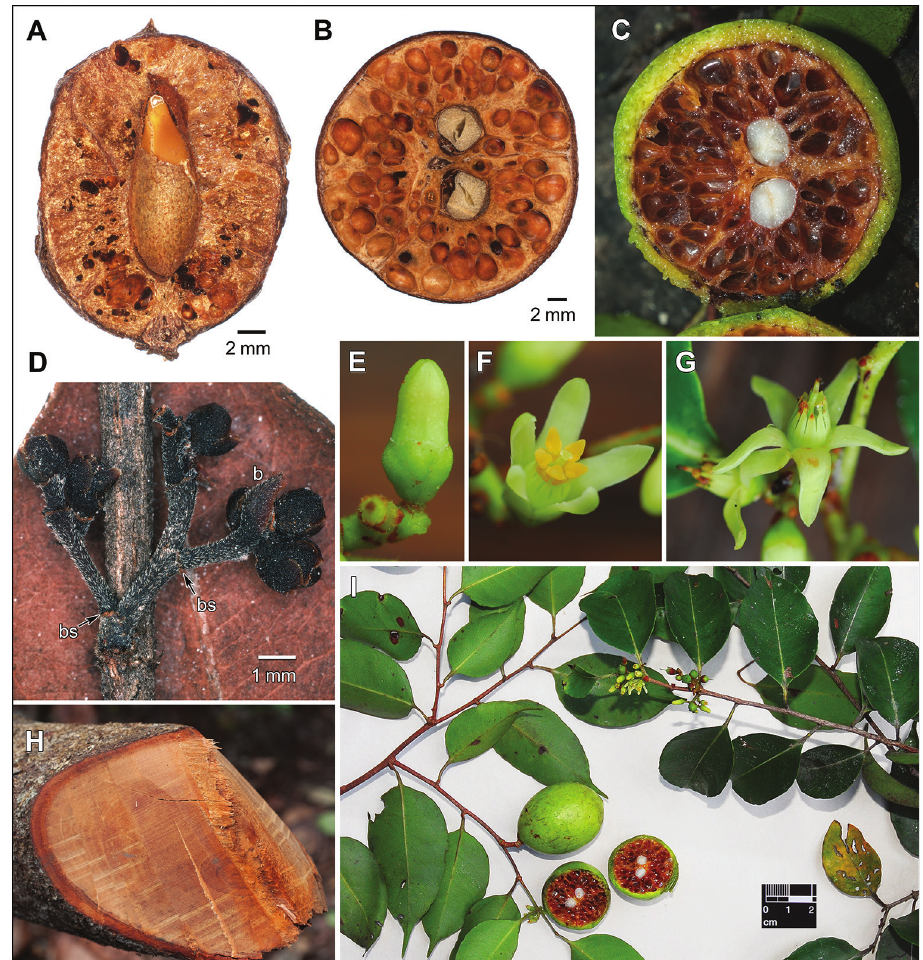
Figure 6 . Macromorphology of Sacoglottis perryi . A Dried fruit with central seed embedded in woody endocarp, longitudinal split along carpel wall (dissected by Cuatrecasas) B dried fruit with 2 central seeds and endocarp lacunae, transverse section C fresh fruit with fleshy yellow-green exocarp and liquid in en- docarp lacunae, transverse section D young inflorescence with bracts intact (b) or fallen leaving bract scars (bs) E mature bud with marginal sepal gland (small red dot in center) F partly open flower with intact anthers G post-anthetic flower H freshly cut trunk I type in life just before pressing. Sources: A Gillespie 2810 B Tripp 2984 C, E–I Redden 7264 D Hoffman 1600 (all